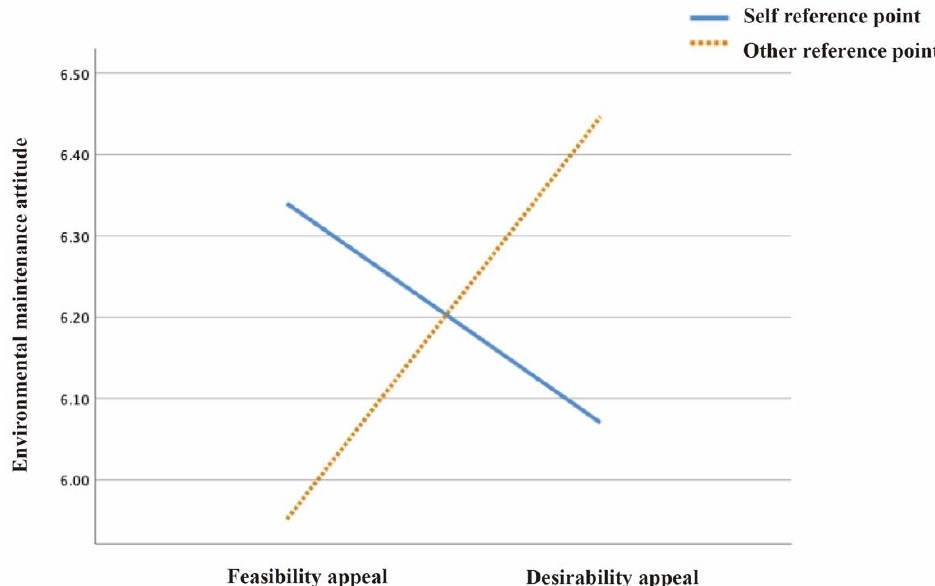
Figure 2. The effect of text appeals on environmental maintenance attitude, assessed by image reference point.